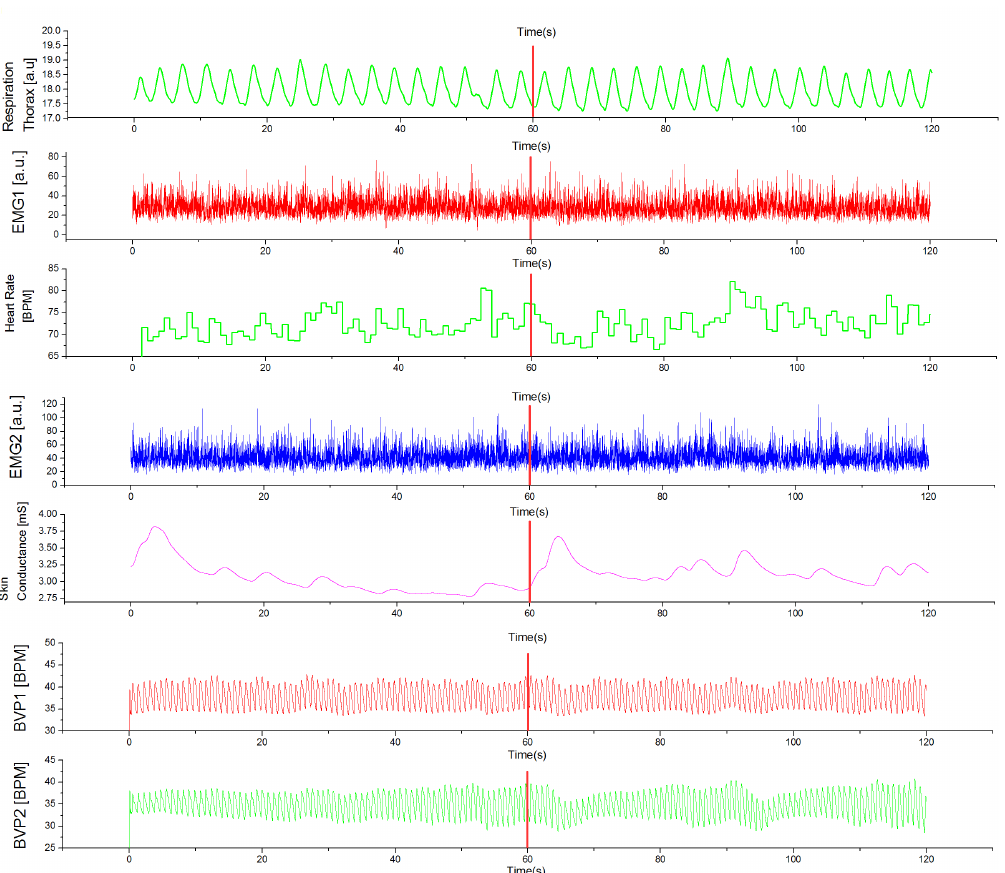
Fig. 2. An example of registered physiological parameters of one of the volunteers. Red line indicates the moment when the shot sound was ¯red.